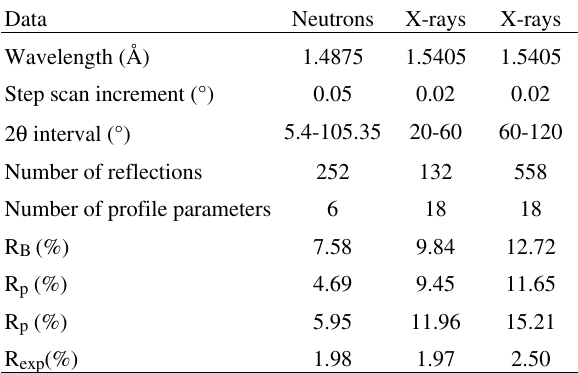
Table 1. Rietveld refinement details for SBN using neutron and X-rays powder diffraction data simultaneously.